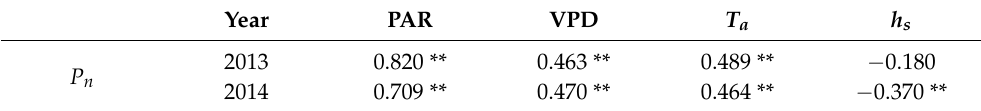
Table 2. Pearson coefficients between environmental parameters and net photosynthesis ( P n ) .